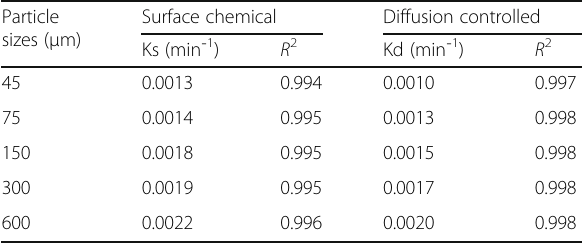
Table 4 Rate constant and R 2 at different ore particle